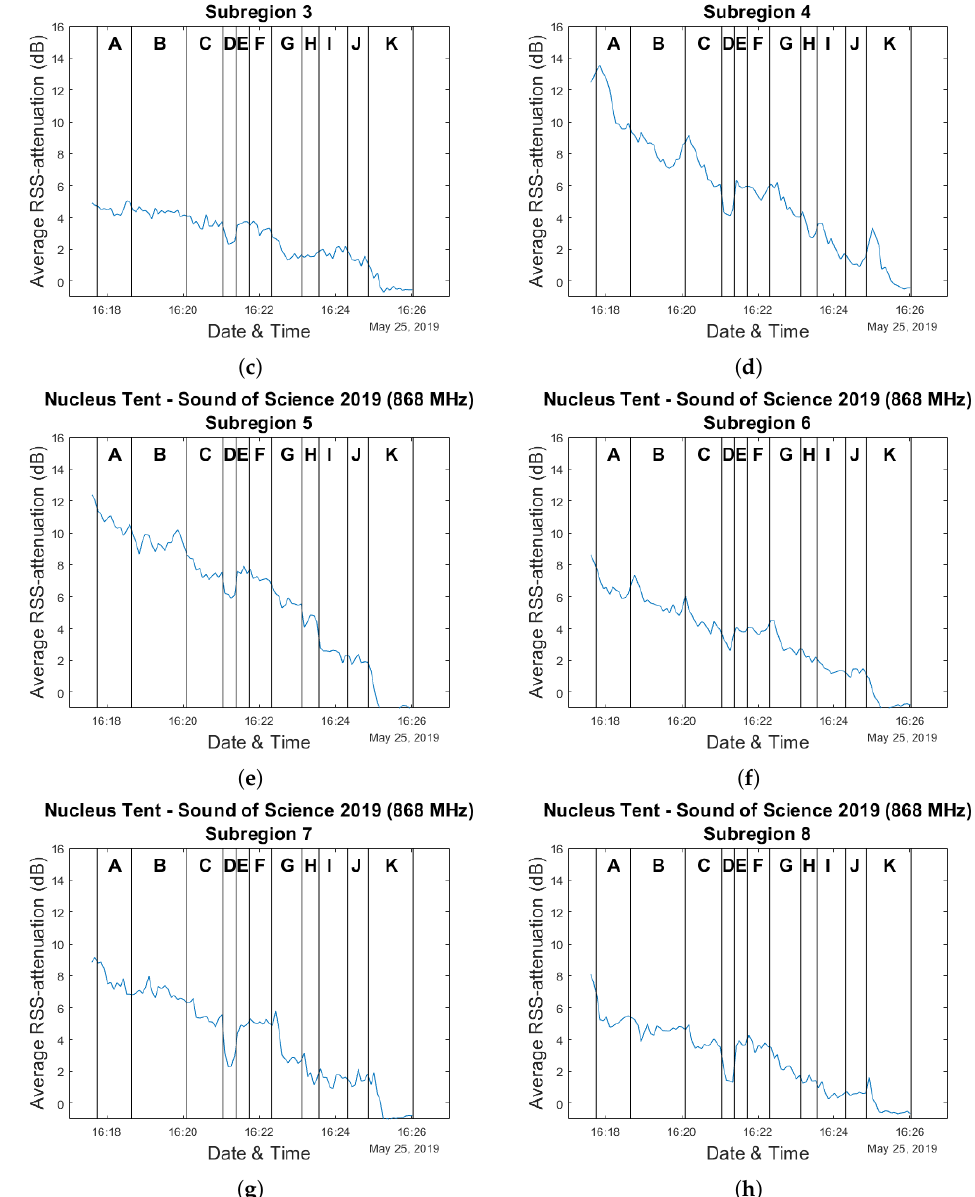
Figure 22. A set of graphs showing the evolution of the average RSS attenuation experienced within each subregion over the course of the experiments performed within the Nucleus tent environment. Plots ( a – h ) correspond to subregions 1 to